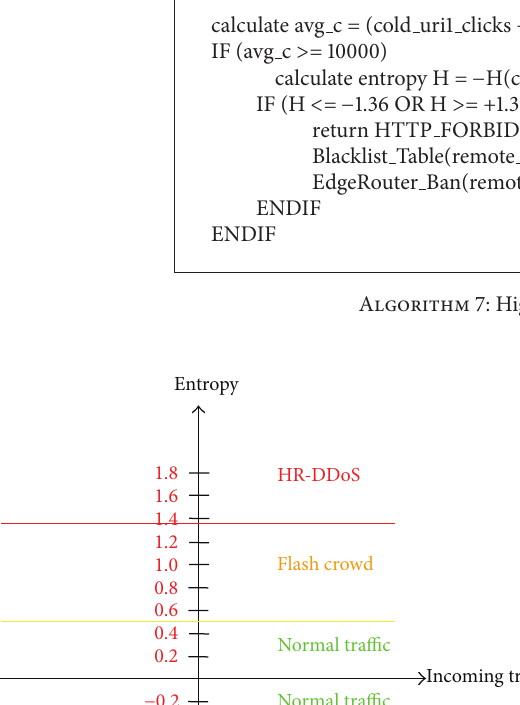
of the web application, which cause high rate DDoS (HR-DDoS)